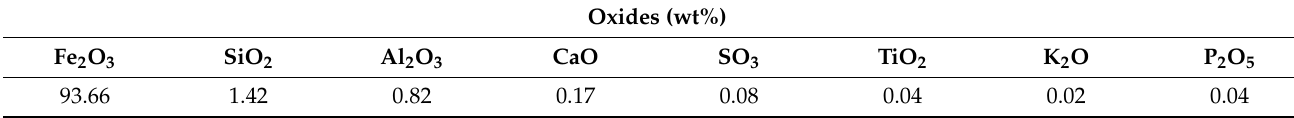
Table 2. Composition of the mill scale.